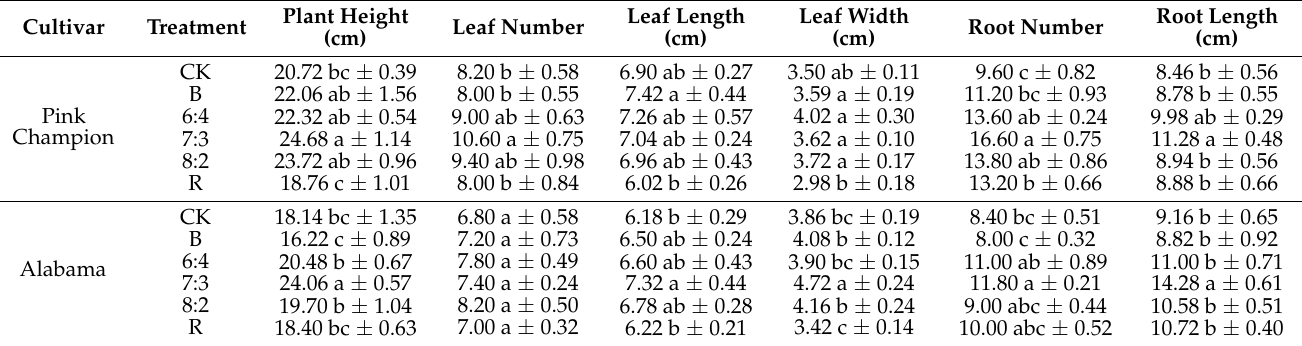
Table 1. Effects of different light qualities on the growth of Anthurium ‘Pink Champion, Alabama’.